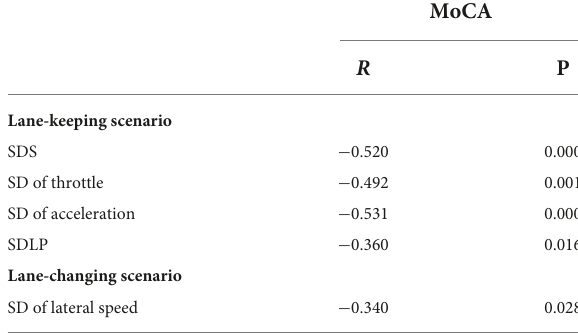
TABLE 3 Correlation between the MoCA scores and driving